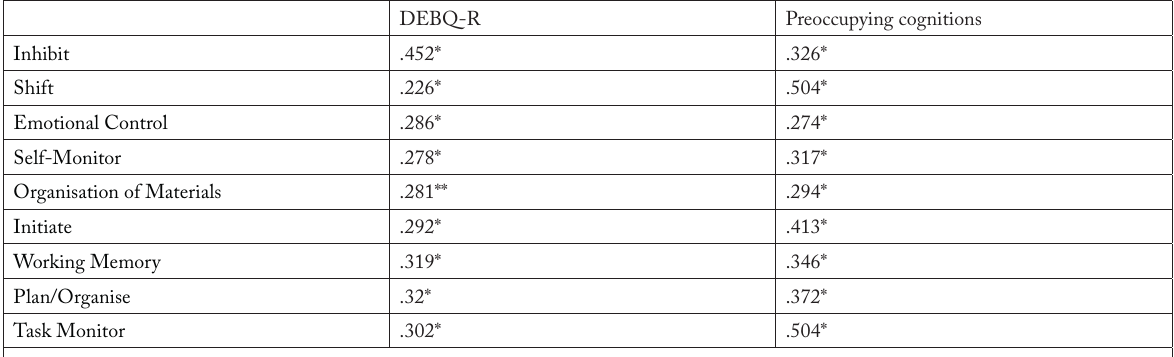
Table 4. Correlations between the nine BRIEF-A subscales and DEBQ-R and Preoccupying